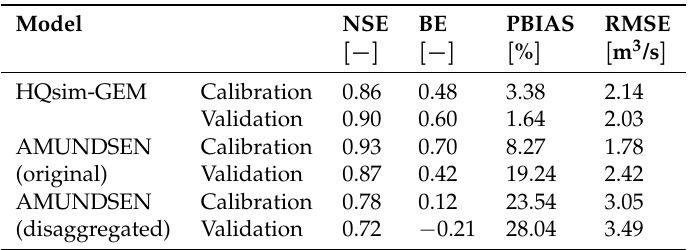
Table 2. Skill scores (Nash–Sutcliffe efficiency NSE, benchmark efficiency BE, percent bias PBIAS and root mean square error RMSE, see Table A1) of the calibration and validation of the Rofenache